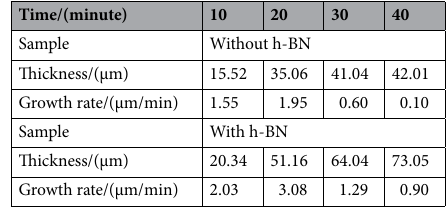
Table 2. Thickness of the coatings at different oxidation